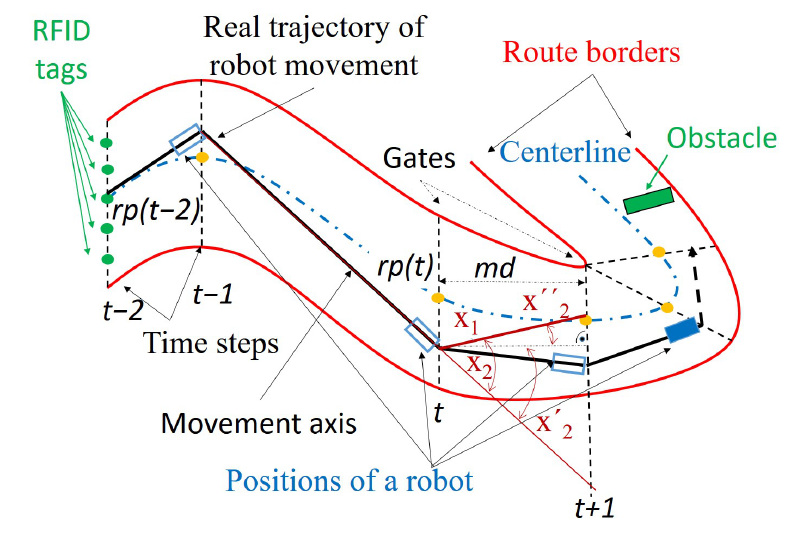
Figure 8. Analysis of control variables for route